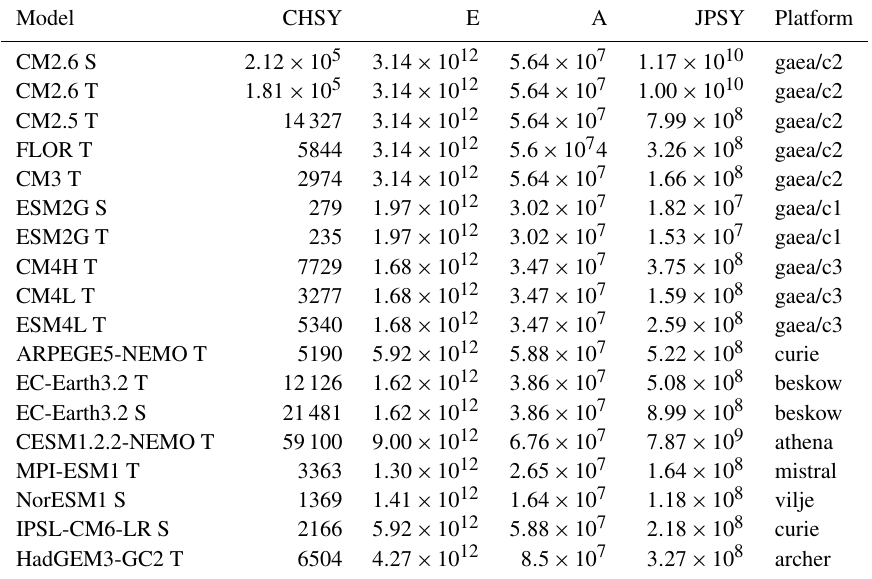
Table 2. Energy cost per simulated year (Joules) in several of the configurations listed in Table 1. See Sect. 4.3 for an explanation of the terms. Energy and aggregate core hours are reported for 1